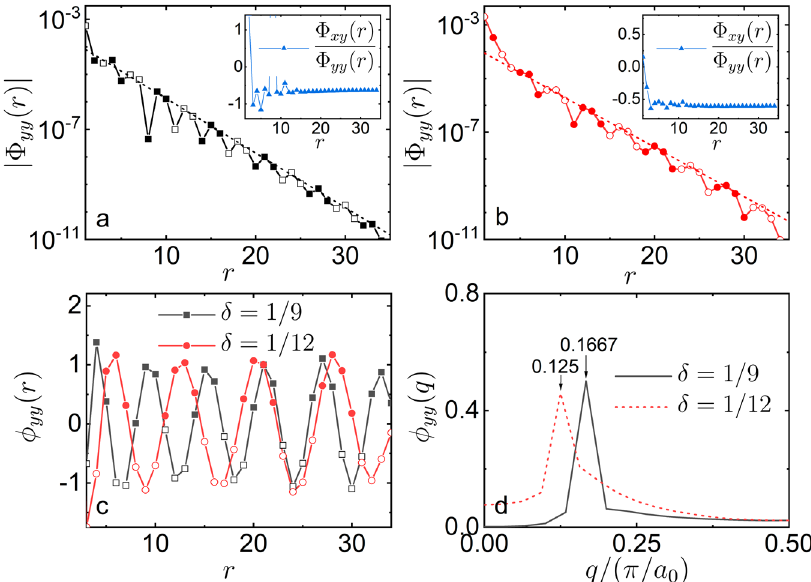
Fig. 2 Superconducting correlations and their spacial oscillation. Superconducting correlations ∣ Φ yy ( r ) ∣ on three-leg cylinder at doping level a δ = 1/9 and b δ = 1/12, where dashed lines denote fi ttings to an exponential function f ð r Þ (cid:4) e (cid:2) r = ξ sc . Insets are the ratio Φ xy ( r )/ Φ yy ( r ) < 0, where the out of phase indicates d -wave type pairing. c The normalized function ϕ yy ( r ) = Φ yy ( r )/ f ( r ) at δ = 1/9 and δ = 1/12, which directly re fl ects the spatial oscillation of Φ yy ( r ). d Fourier transformation ϕ yy ( q ) of ϕ yy ( r ) at δ = 1/12 and δ = 1/9, where peaks lie at Q = 3 πδ /2 a 0 giving the total momentum of the pairing. Note that fi lled (open) symbols denote positive (negative)